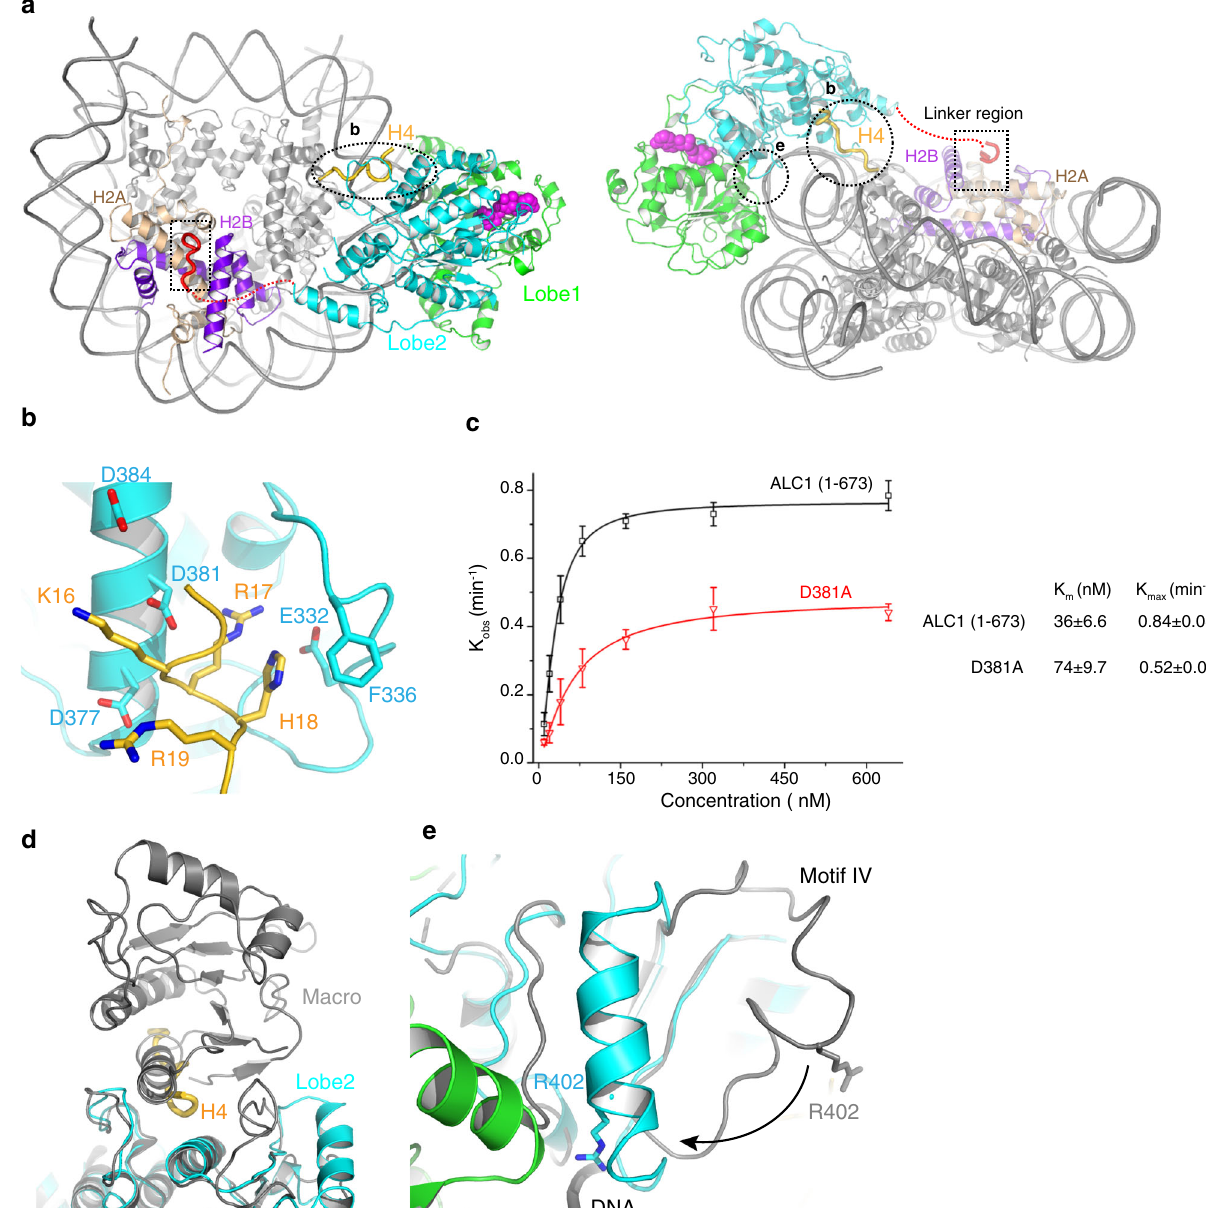
Fig. 3 Mechanisms of ALC1 activation by the nucleosome. a Top and front views of the ALC1-nucleosome complex. The linker region of ALC1 bound to the surface of the nucleosome is colored red, and enlarged for analyses in Fig. 4; the H4 tail bound to ALC1 is colored gold. The encircled regions are enlarged for analyses in b and e. b Interaction between ALC1 and the H4 tail. c The observed remodeling rates of ALC1 (1-673) and D381A mutant at multiple enzyme concentrations. The data were fi t with a hyperbola function, and the resulted K m and K max were shown on the right. Error bars indicate standard deviations for three independent measurements and the measure of center for the error bars is the mean value. d , e Structural comparisons of the autoinhibited (colored gray) and nucleosome-bound (color coded) states, around the H4-binding surface ( d ) and motif IV ( e ). The structures of lobe 2 are